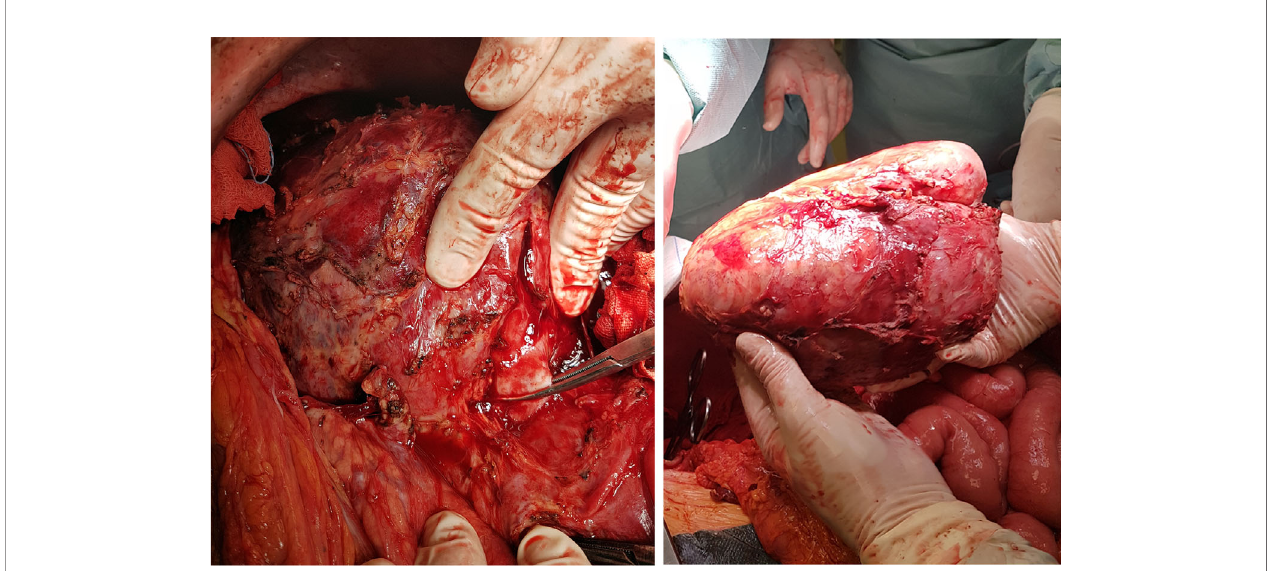
FIGURE 4 | Surgical removal of the necrotic primary tumor together with the left kidney after resolution of the descending abscess. The left renal vein is